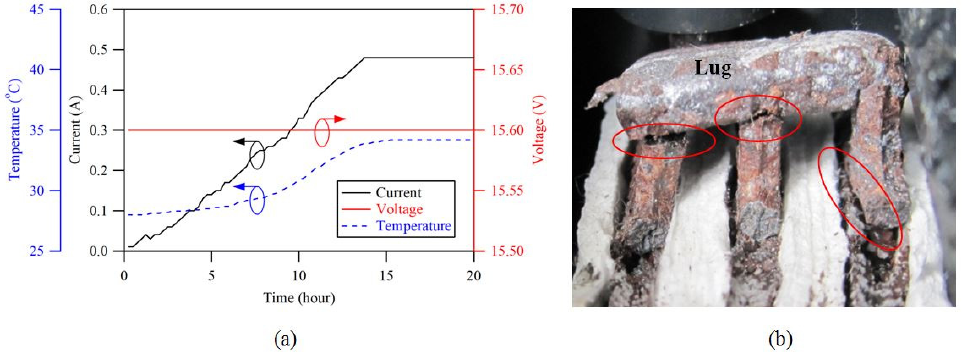
Figure 6. Scenario two: ( a ) charging profile of the open-circuited batteries when charging at 15.6 V; ( b ) broken connections between lug and plates.